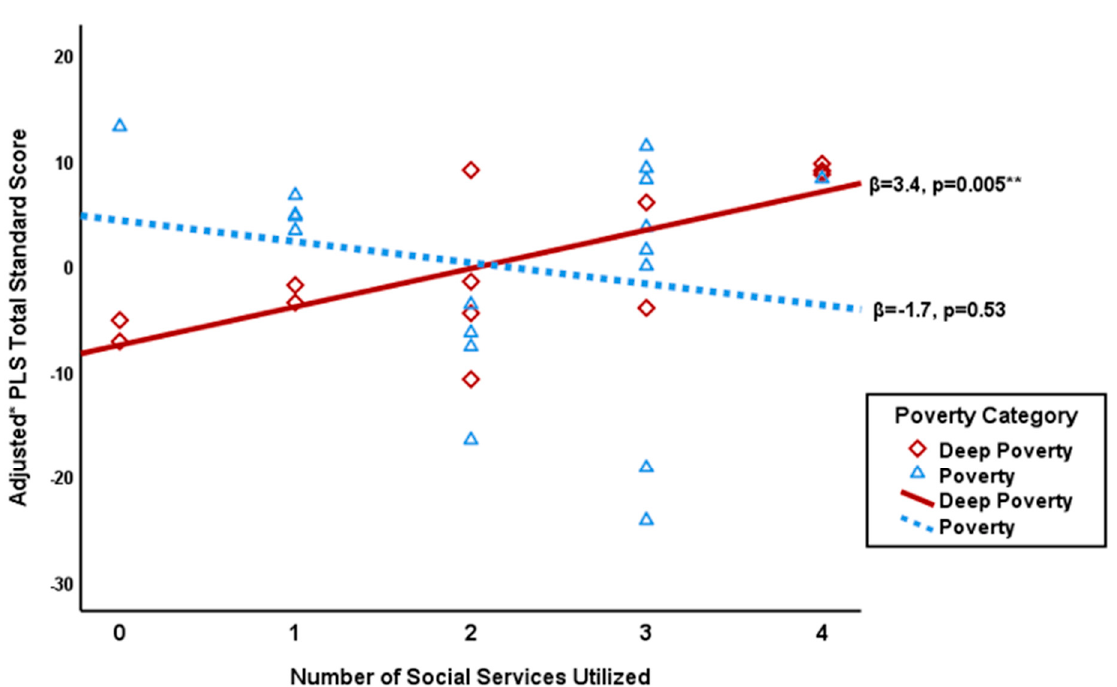
Figure 1. Social services utilized vs. adjusted* PLS total score stratified by poverty category. *Adjusted for average parental education and child age ** p < 0.01.